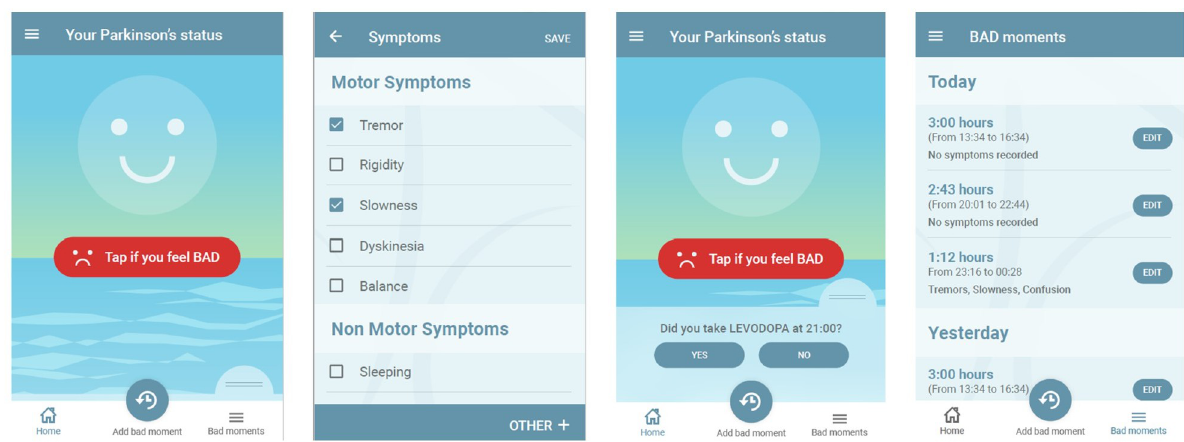
Fig 3. Examples of the mobile app features (from left to right: the main page, adding of symptoms, medication reminder and list of reported symptoms).